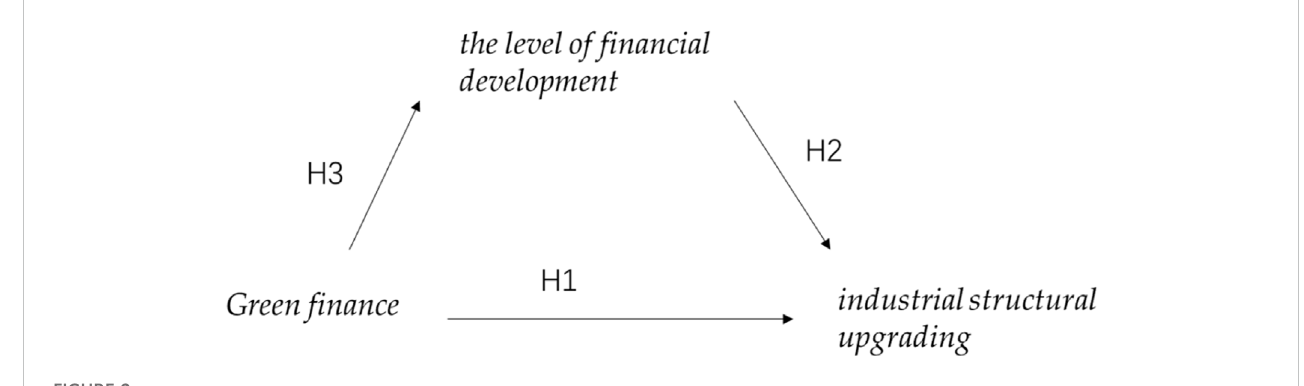
FIGURE 2 Hypothetical